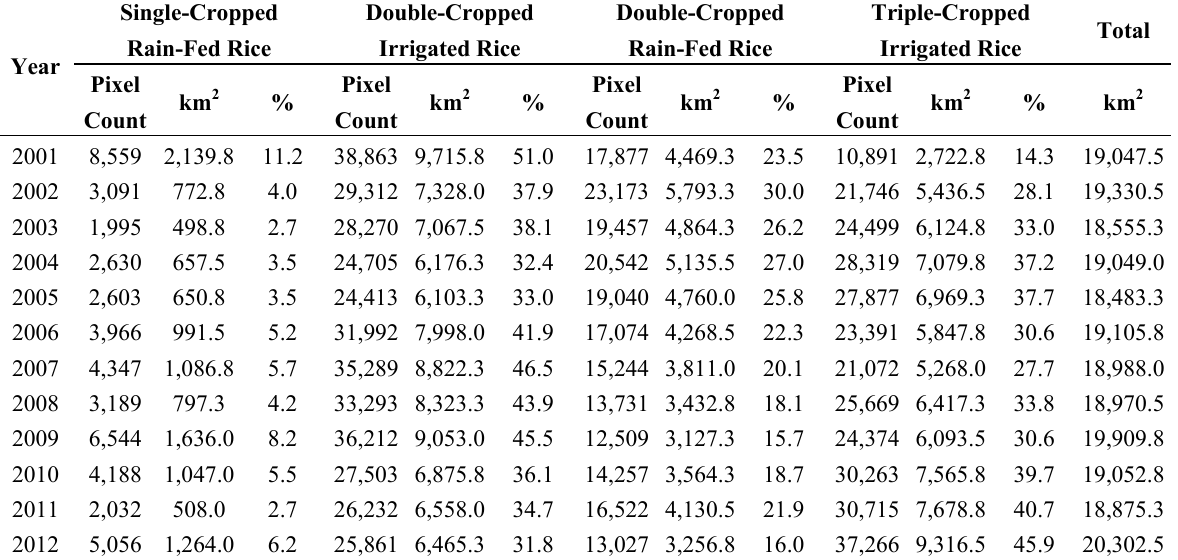
Table 3. Harvesting areas of rice cropping systems during 2001 to